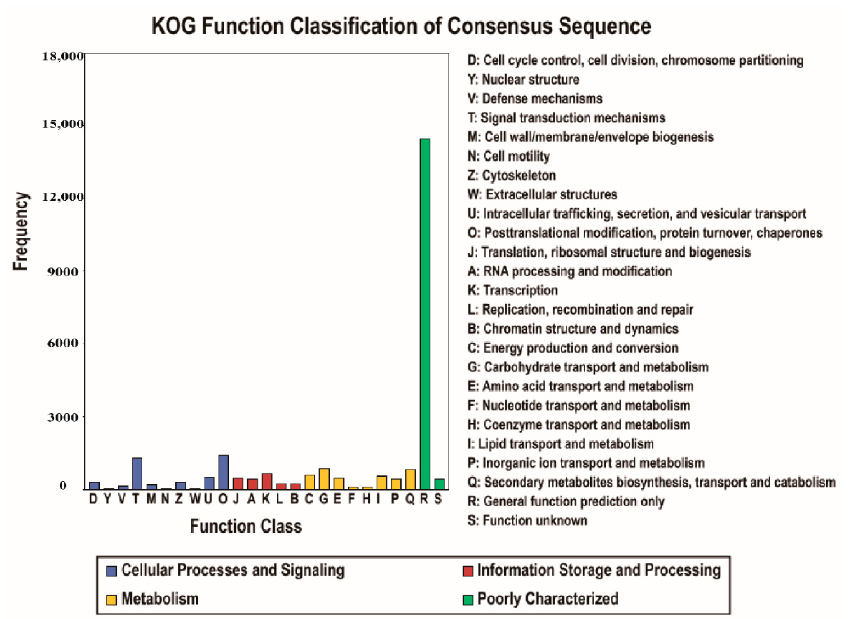
Figure 3. Eukaryotic Ortholog Groups (KOG) functional classification of consensus sequence for Larix kaempferi. In total, 23,331 unigenes were distributed in 25 KOG function classes.